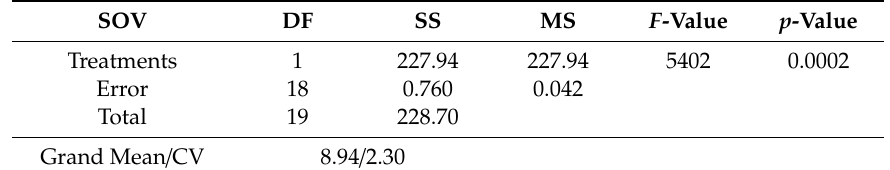
Table A14. Influence on the total number of leaves / plants of PeBL1-treated and control cucumber